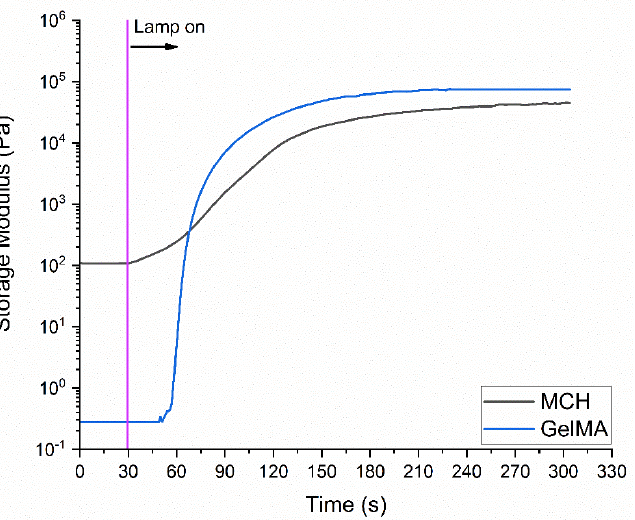
Figure 4. Photorheology curves recorded for the MCH formulation (3 wt% solubilized in acetic acid-water solution containing 2 phr of Irgacure 2959), GelMA formulation (10 wt% solubilized in distilled water containing 1 phr of Irgacure 2959).